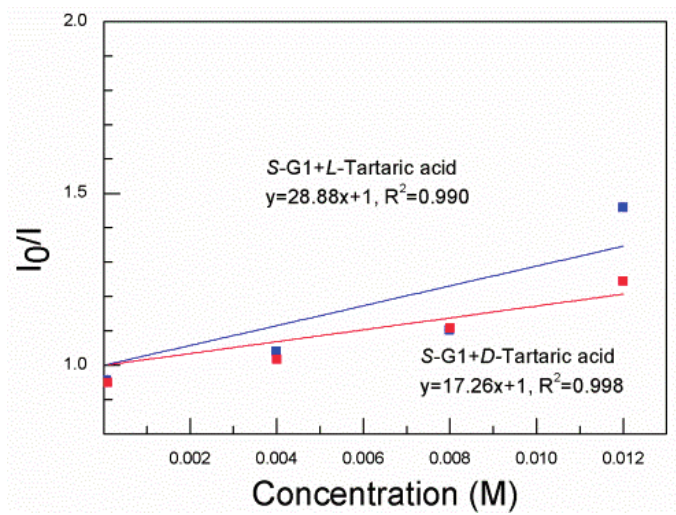
Figure 3. Stern–Völmer plot of S -G1 (8 × 10 − 5 mol·L − 1 ) in EtOH in the presence of D -tartaric acid and L -tartaric acid ( λ ex = 330